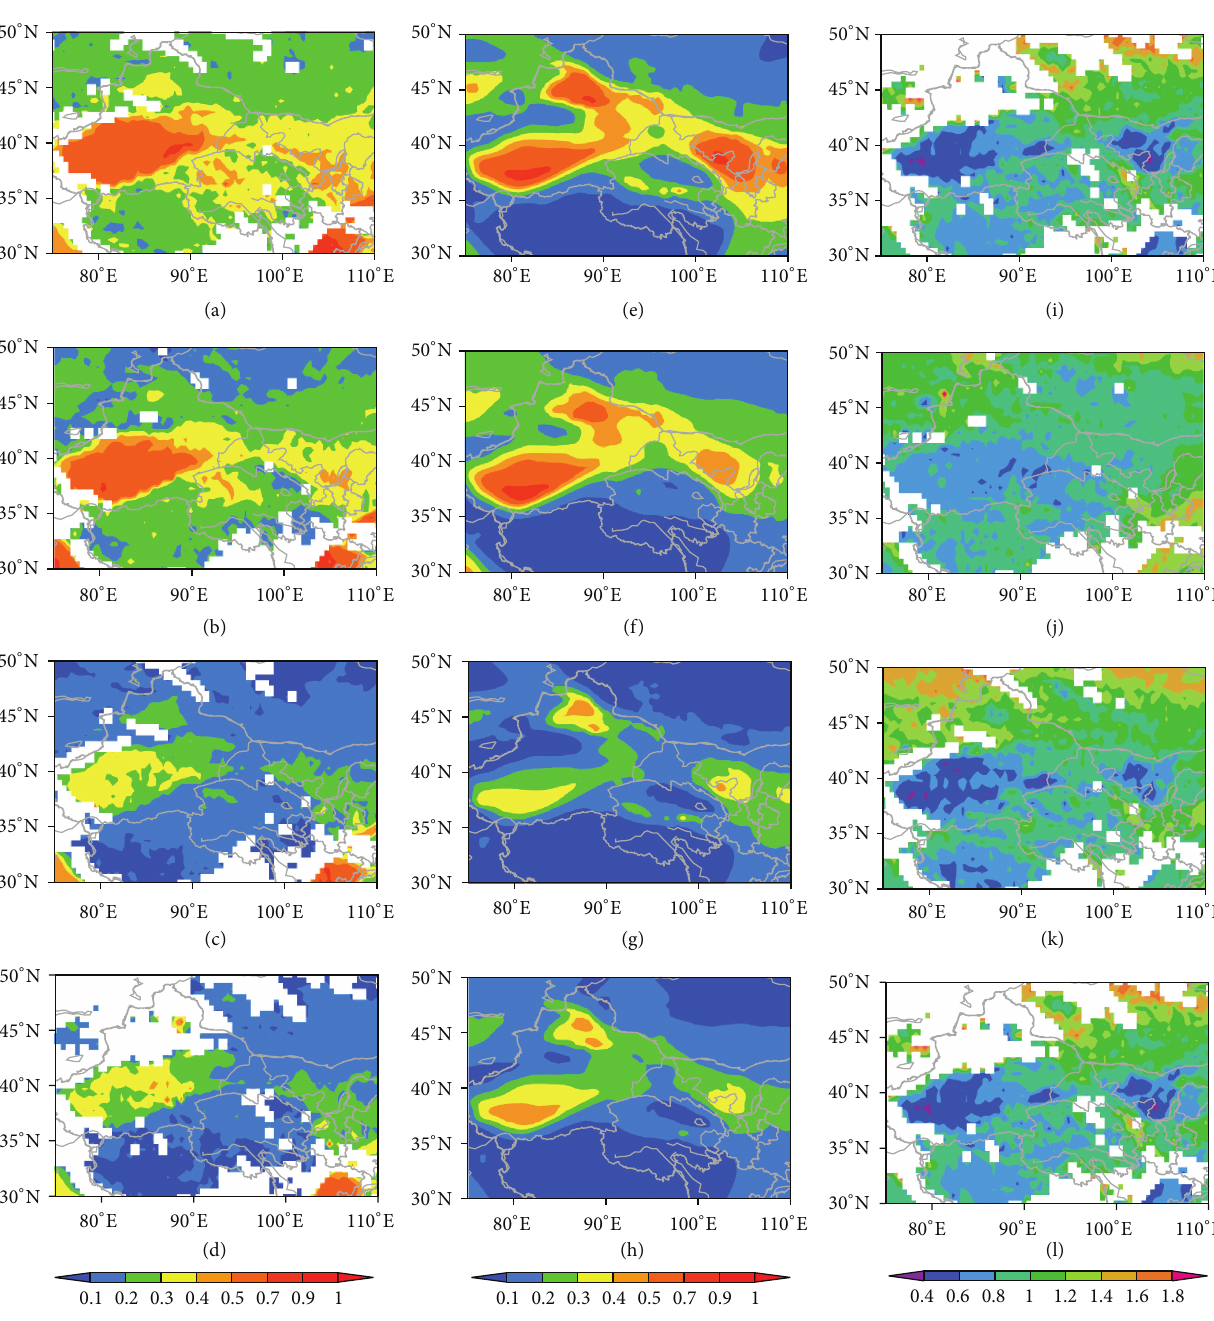
Figure3:MISR-retrievedAOD(555 nm)(left-handpanels),theRegCM4simulateddustAOD(550 nm)(middlepanels),andMISR-retrieved Angstrom exponent (right-hand panels) averaged in (a, b) spring, (c, d) summer, (e, f) autumn, and (g, h) winter during 2000–2009